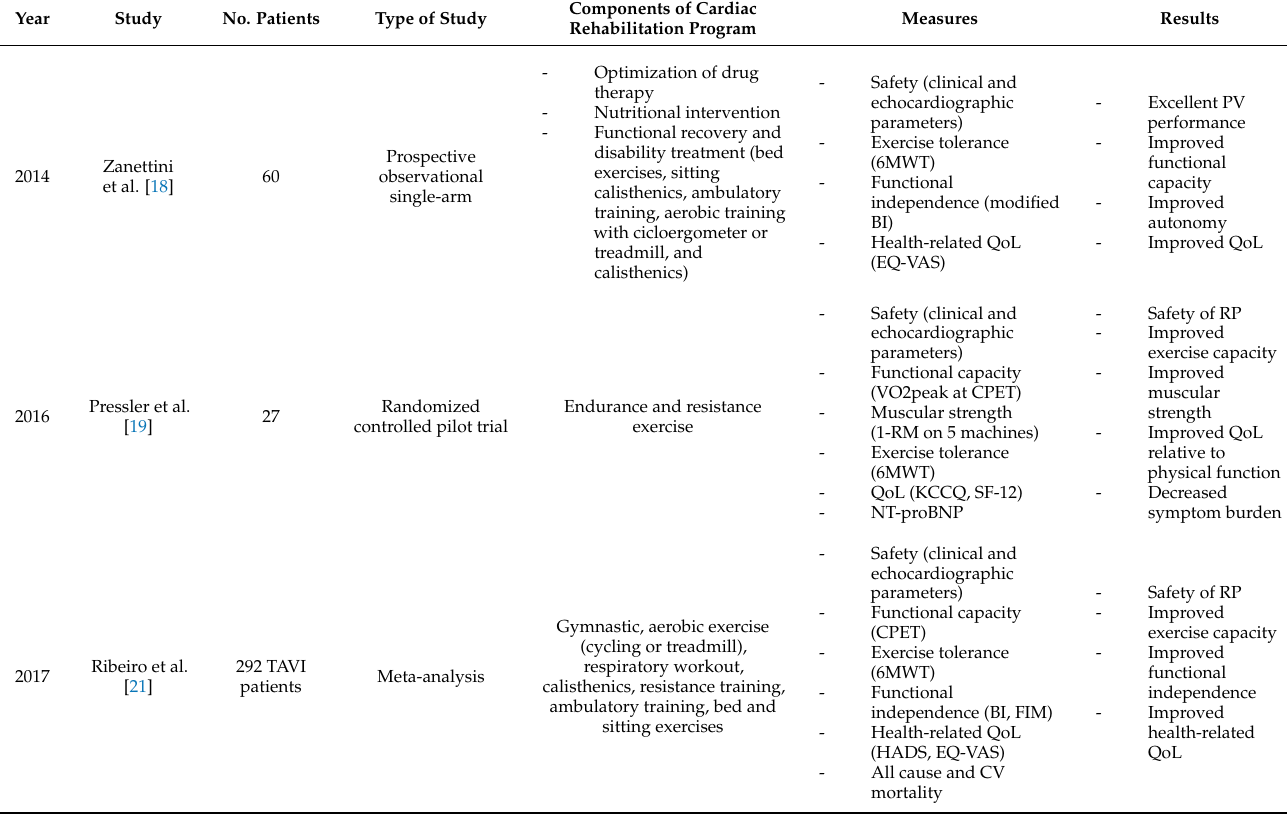
Table 1. Overview of the main clinical studies on cardiac rehabilitation after transcatheter aortic valve implantation. Year